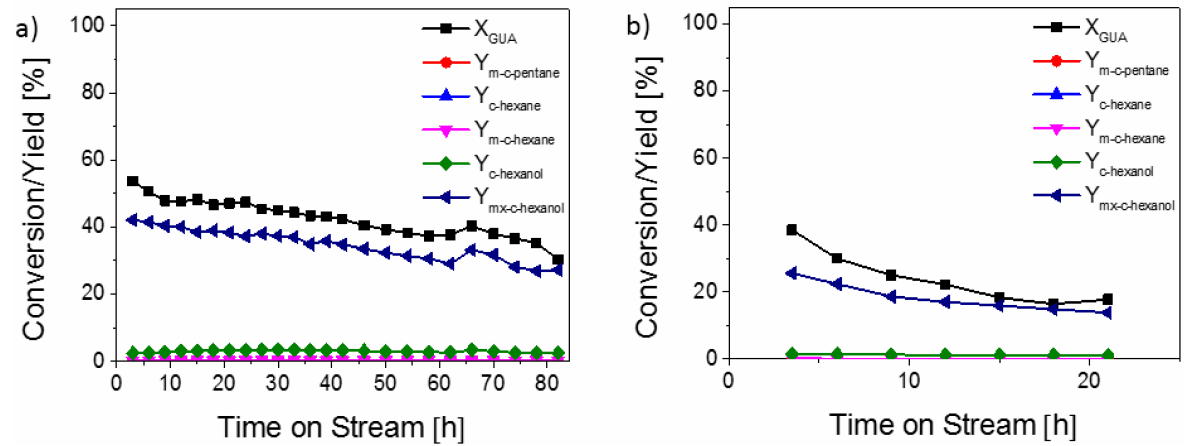
Figure 2. Conversion of guaiacol over ( a ) 5 wt. % Pt/SiO 2 and ( b ) 1 wt. % Pt/SiO 2 (conditions: 0.3 mL/min 5% GUA in 1-octanol, 500 mL/min 80% H 2 in N 2 , T = 250 °C, p = 100 bar, 1 g catalyst; GUA = guaiacol, m = methyl, mx = methoxy, c =